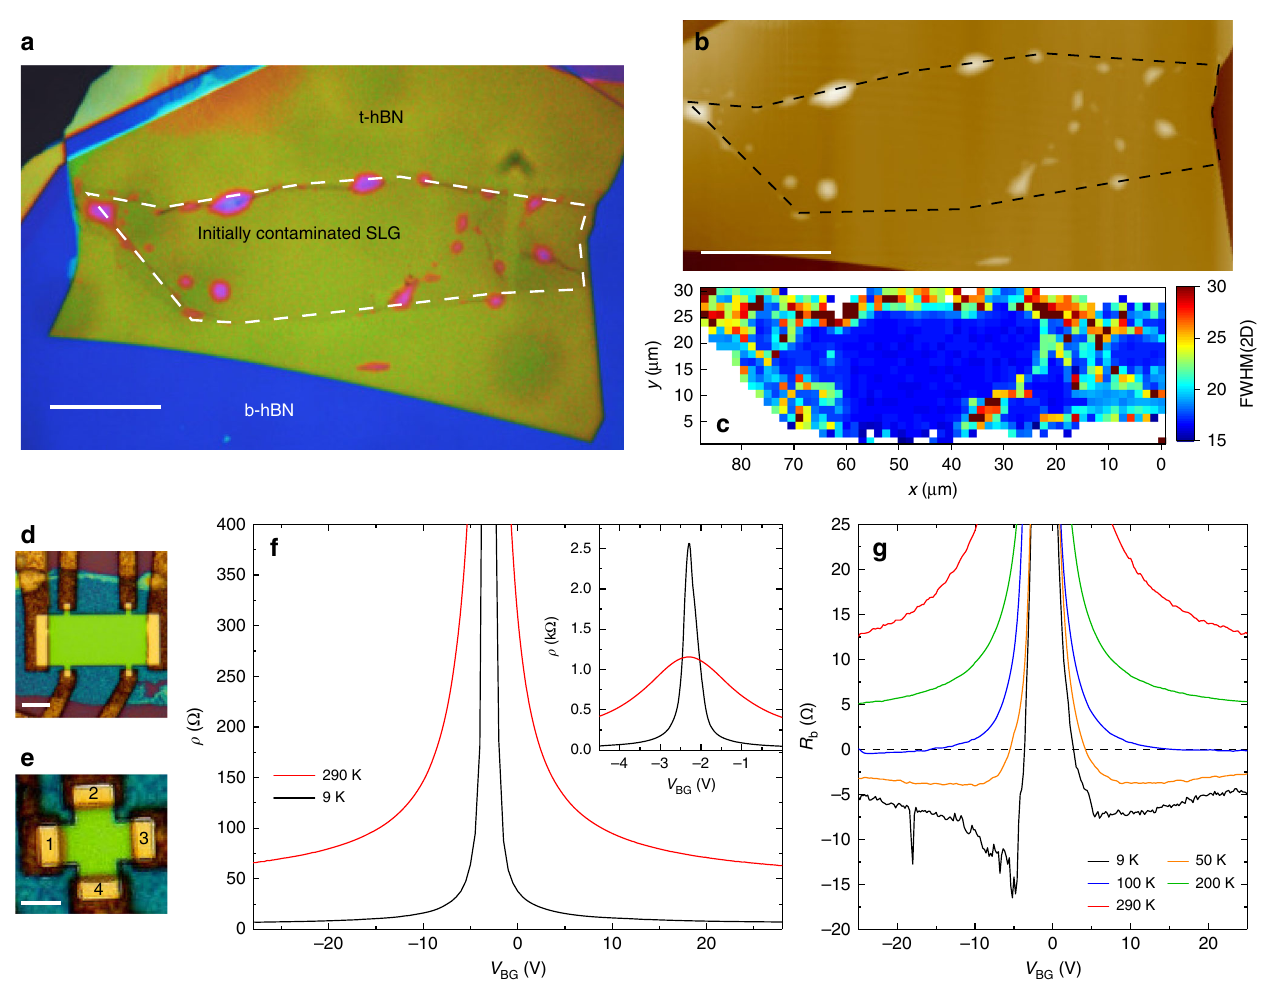
Fig. 8 Characterization of heterostructures produced using SLG exposed to both polymer residuals and solvents. a False color optical image. SLG is indicated by the white dashed line. Blisters have been pushed to the SLG edges. Scale bar 20 μ m. b AFM scan of the sample. The black dashed line shows the SLG. c Spatial map of FWHM(2D) of the sample, taken at an excitation wavelength of 514 nm. d Hall bar processed from the sample. Scale bar 5 μ m. e Hall cross with arm width 2 μ m from the same heterostructure. Scale bar 2 μ m. The contacts are labeled 1 – 4. f Resistivity at 9 and 290 K. Inset: Resistivity at 9 and 290 K plotted close to CNP. g Bend resistance measurements of Hall cross in b as a function of